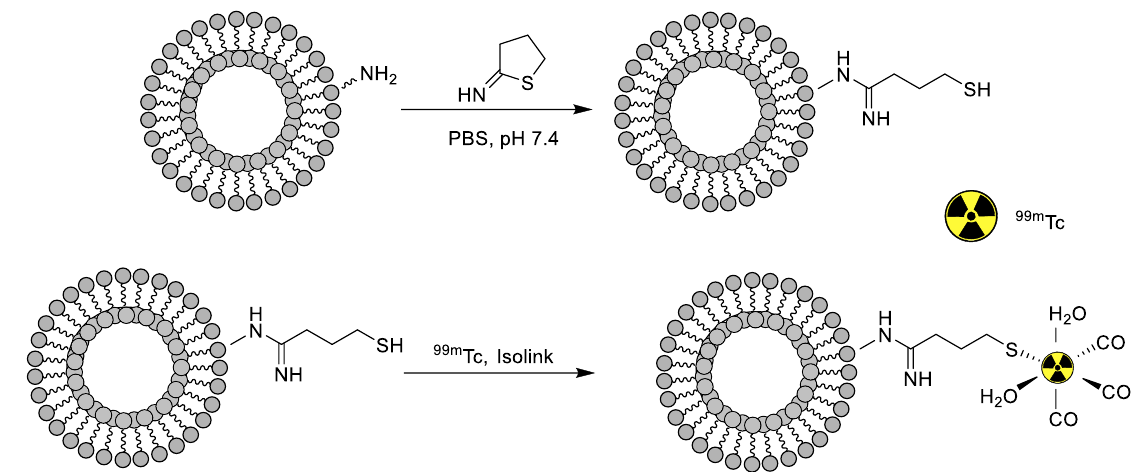
Figure 12. The surface modification of liposomes using 2-iminothiolane and 99m Tc radiolabeling [72].